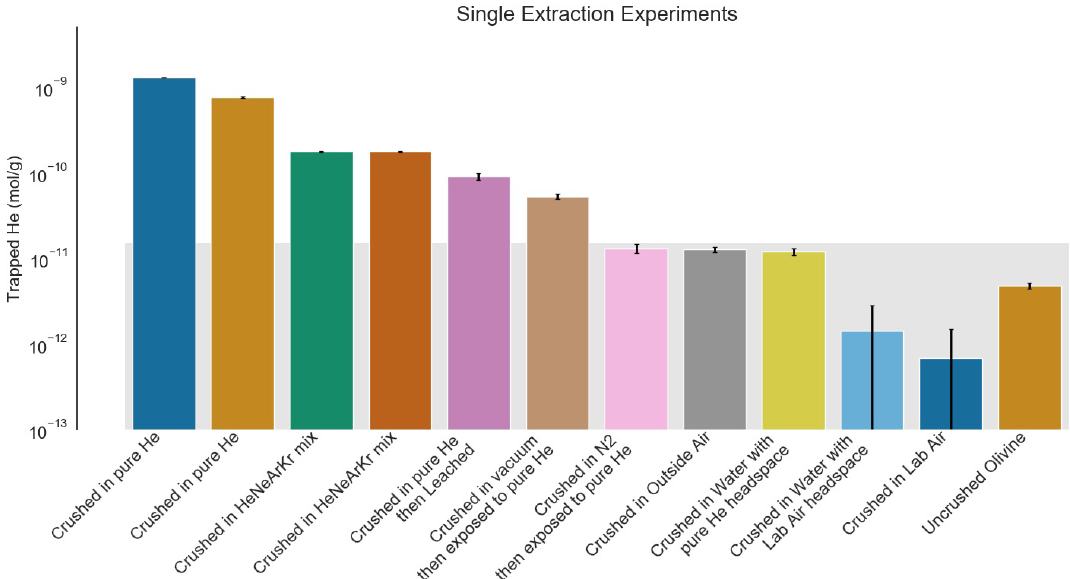
Figure 2. He trapped by crushing process in single-step follow-up experiments. The gray background rectangle shows the approximate background level of the experiment based on the variable natural He content in San Carlos olivine (Mohapatra and Murty, 2000; this work). All samples were sieved to a size range of 37–50µm to reduce variability from sampling. Analytical standard errors shown are 2 σ and are small compared to both the natural background and the He enrichment measured in these experiments. The samples crushed in the presence of pure or enriched He show significant enrichments in He. Acid leaching reduces the amount of He contamination but not to background levels. The sample crushed under vacuum and then immediately exposed to pure He also shows a He enrichment, but it is only a few percent of the enrichment seen in the samples exposed to He during crushing. Samples crushed in a neutral atmosphere and then exposed to He and the sample crushed under water with a pure He atmosphere are indistinguishable from